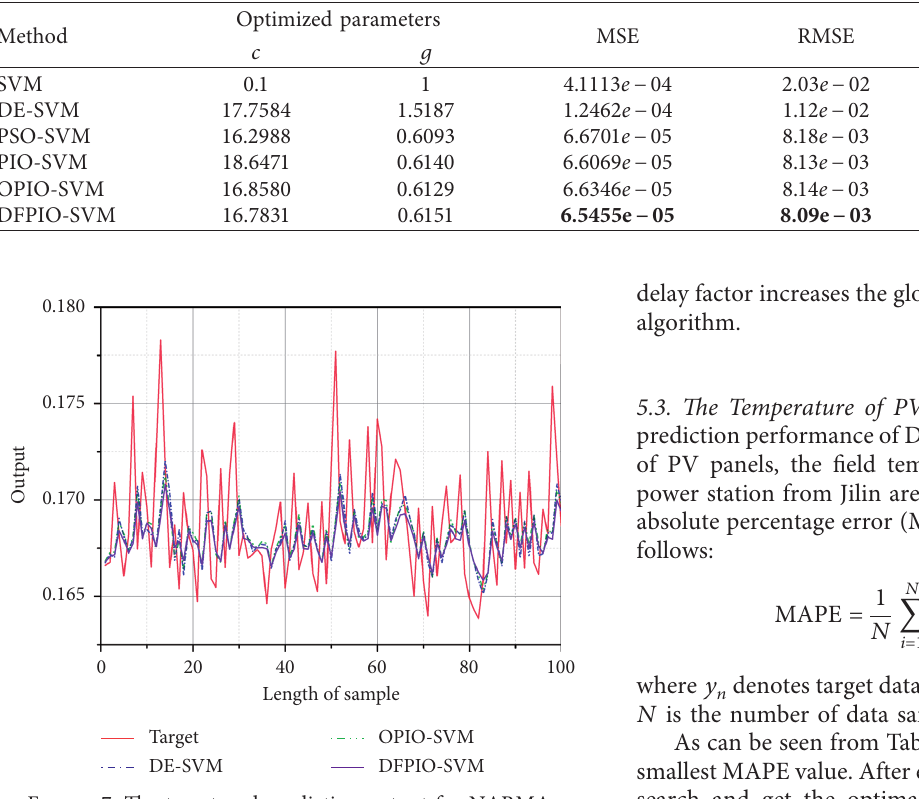
Figure 7: The target and prediction output for NARMA.